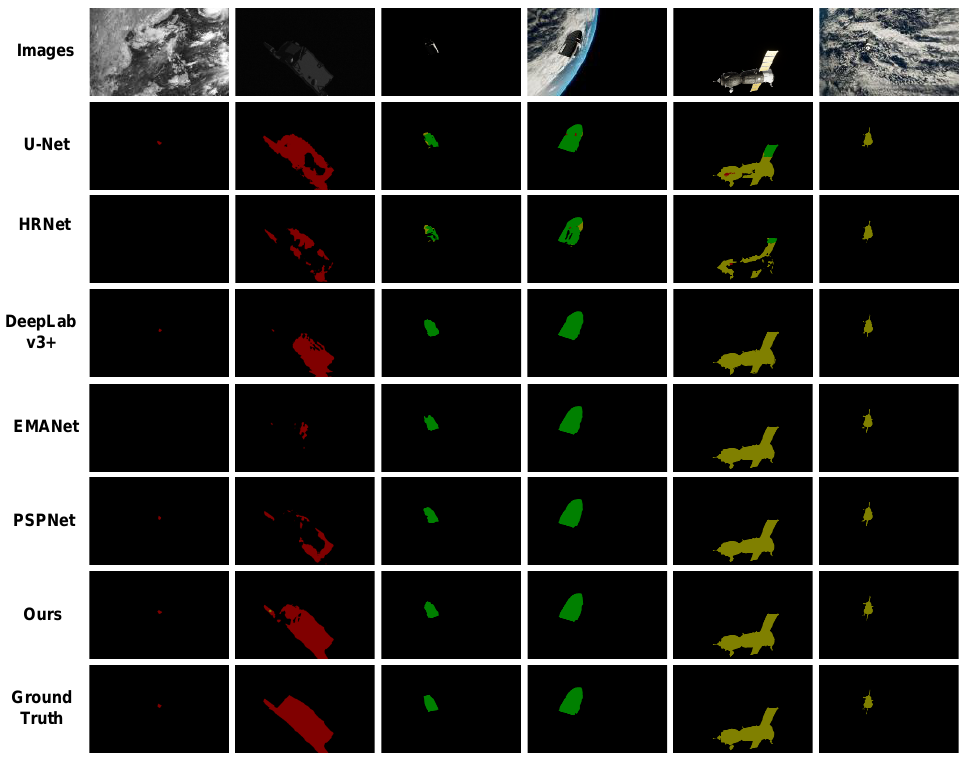
Figure 12. Experimental results and comparison with other methods.